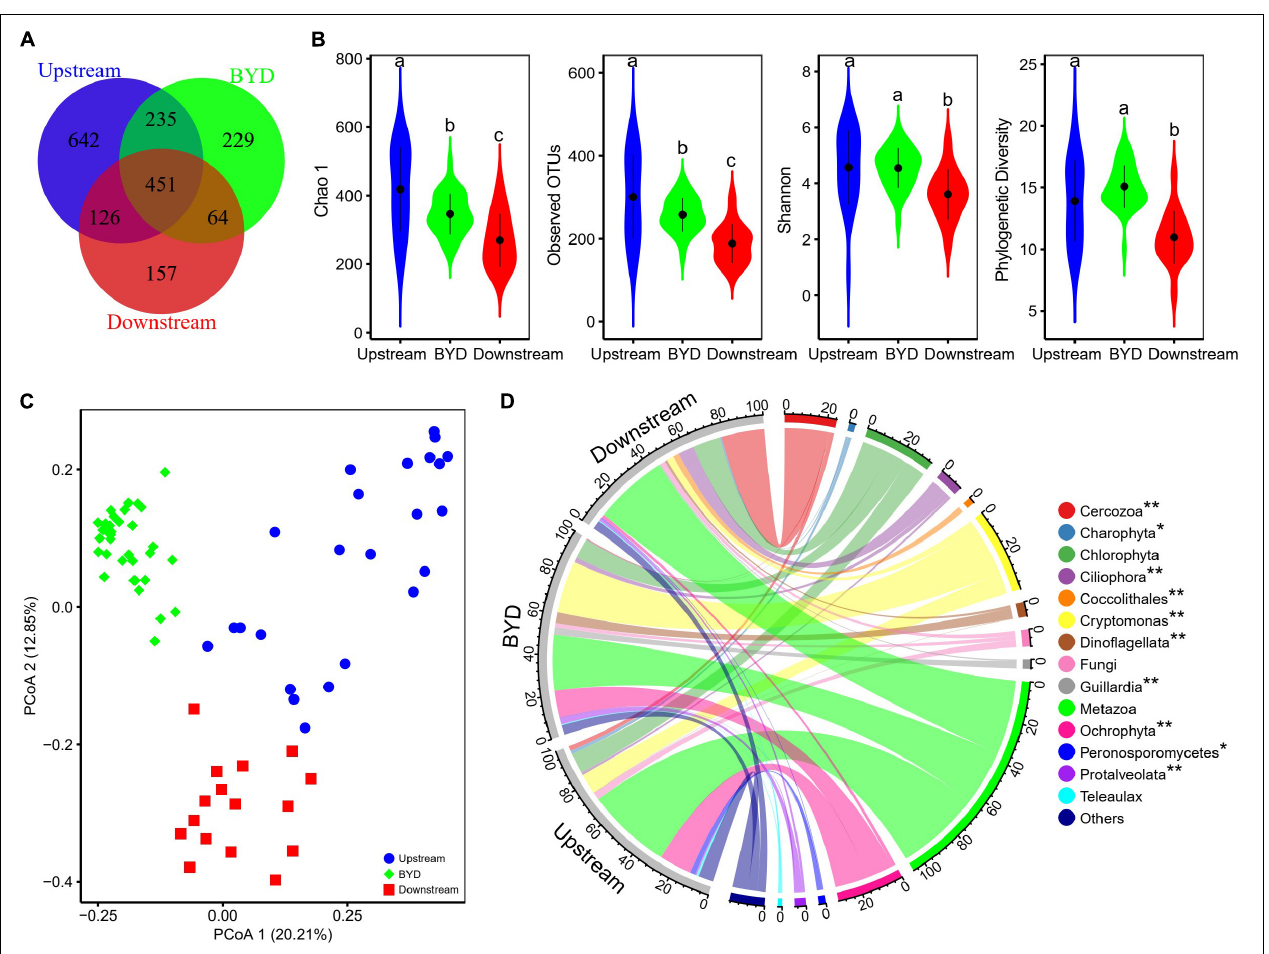
FIGURE 2 | Basic differences of microeukaryotic communities along the lentic-lotic continuum in all three areas, including upstream, BYD, and downstream. (A) Venn diagram showing the unique and shared OTUs within and between three study areas. (B) Alpha diversity differences among three study areas. Different letters indicate the significant level at P < 0.05 determined by ANOVA. (C) Principal coordinates analysis (PCoA) based on Bray–Curtis distance in terms of the relative abundance of OTUs. (D) Chord diagram showing taxonomic composition and its differences of the microeukaryotic communities in three study areas. Only the lineages with an average relative abundance > 1% are shown. The significant differences were shown in “*” ( p < 0.05) and “**” ( p <